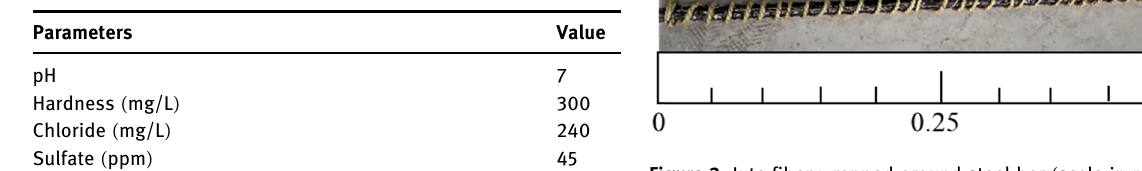
Table 2: Characteristics of water used